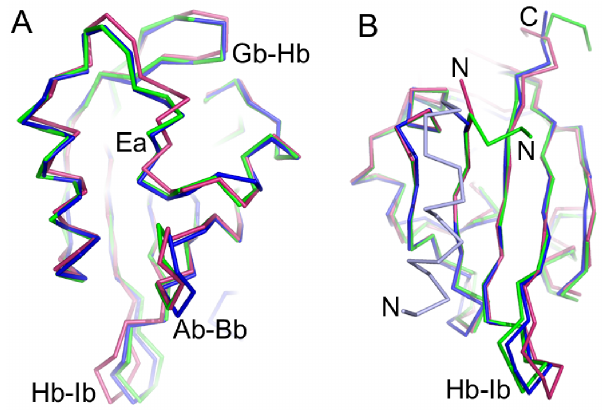
Figure 2. C a representation of PAS domains from three different channels. a) View of the helical face of PAS domains. b) View of the b -sheet face of PAS domains. Colors are: hERG in redbrick, mEAG in green and dELK in blue. The N-terminal helix in dELK PAS domain (absent in the other two structures) is shown in light blue. N- and C- terminal are labeled in b). Several structural features discussed in the text are labeled.